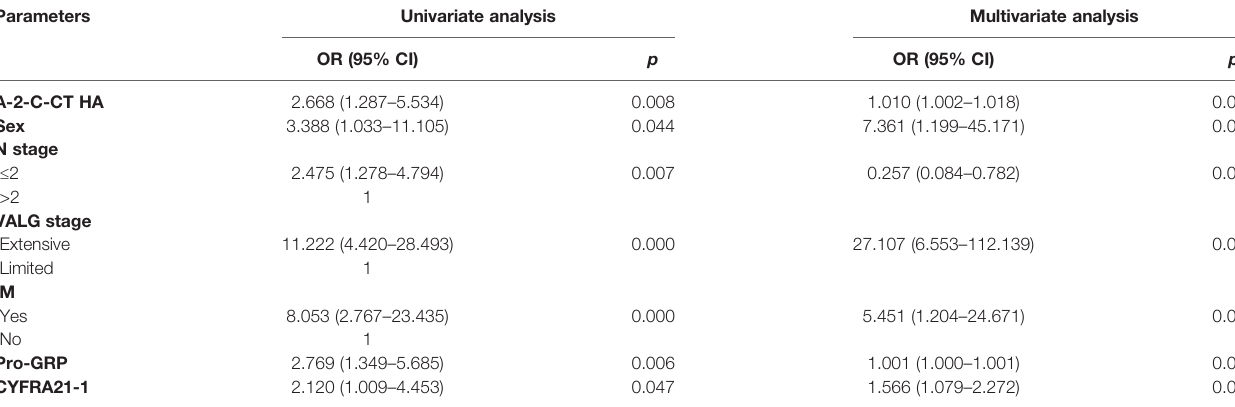
TABLE 3 | Univariate and multivariate Cox regression analyses of variables considered for OS of SCLC patients. Parameters